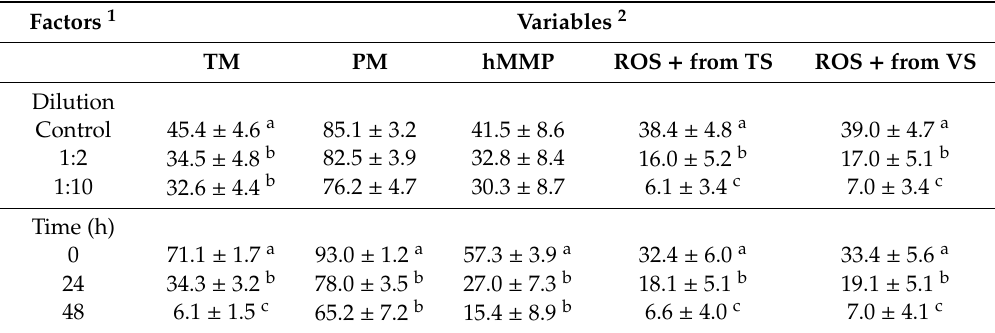
Table 5. E ff ect of duration of storage and sperm concentration on motility and kinetics, mitochondria polarisation and oxidative response after storage at 5 ◦